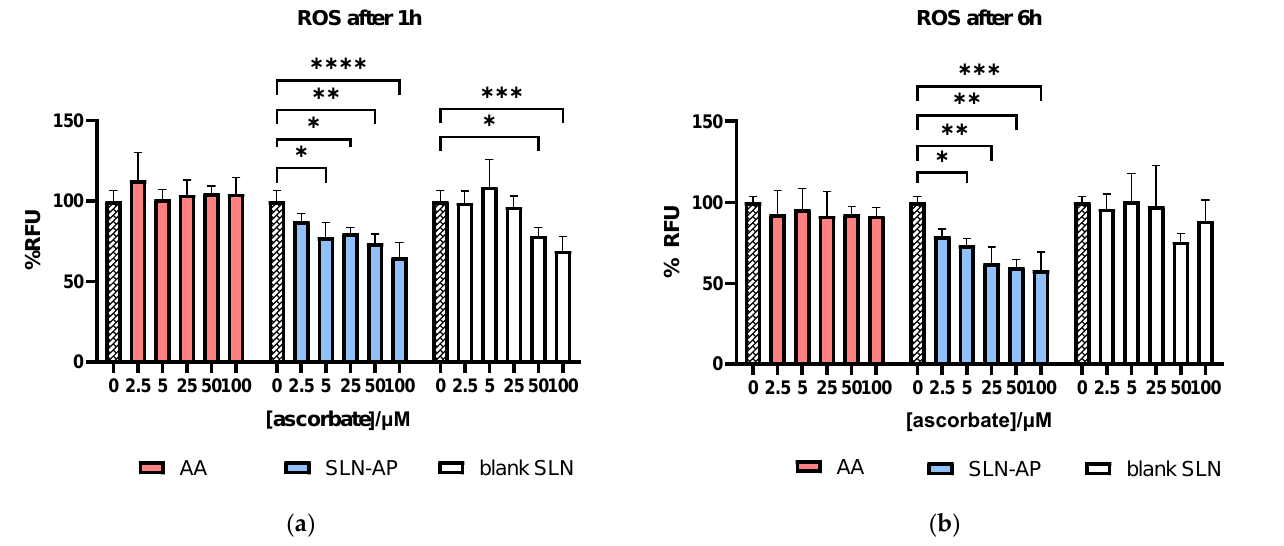
Figure 7. In vitro ROS analysis in cell line U2OS. Cells were treated with AA in free form, SLN-AP and blank SLN for 1 h ( a ) and 6 h ( b ). Fluorescence was measured at 490 nm/570 nm. All treatments were normalized to ascorbate composition. Data are expressed as percent of negative control, mean ± sd, n = 3. Two-way ANOVA was performed with Dunnet’s correction. Statistical significance: * p ≤ 0.05, ** p ≤ 0.01, *** p ≤ 0.001, **** p ≤ 0.0001 .